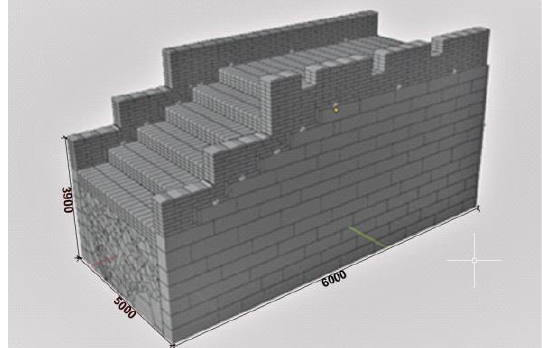
Figure 16. Sloped section model of the Great Wall.